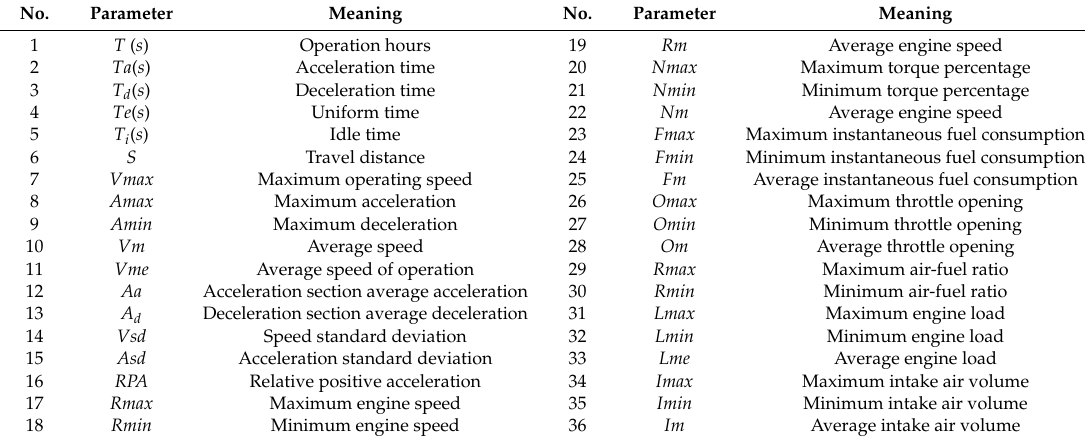
Table 2. Vehicle driving data feature setting.